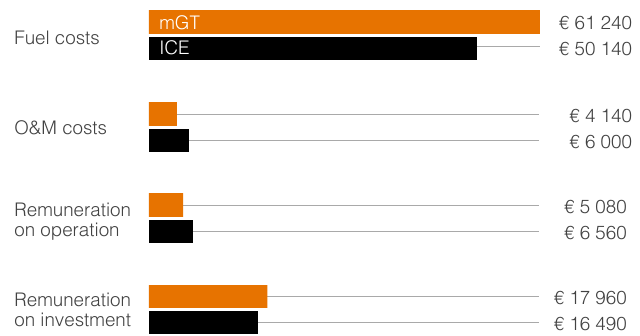
Figure 15. Effect of Spanish policies: the remuneration on operation amounts to a similar value to the O&M costs but it is still very far from the fuel